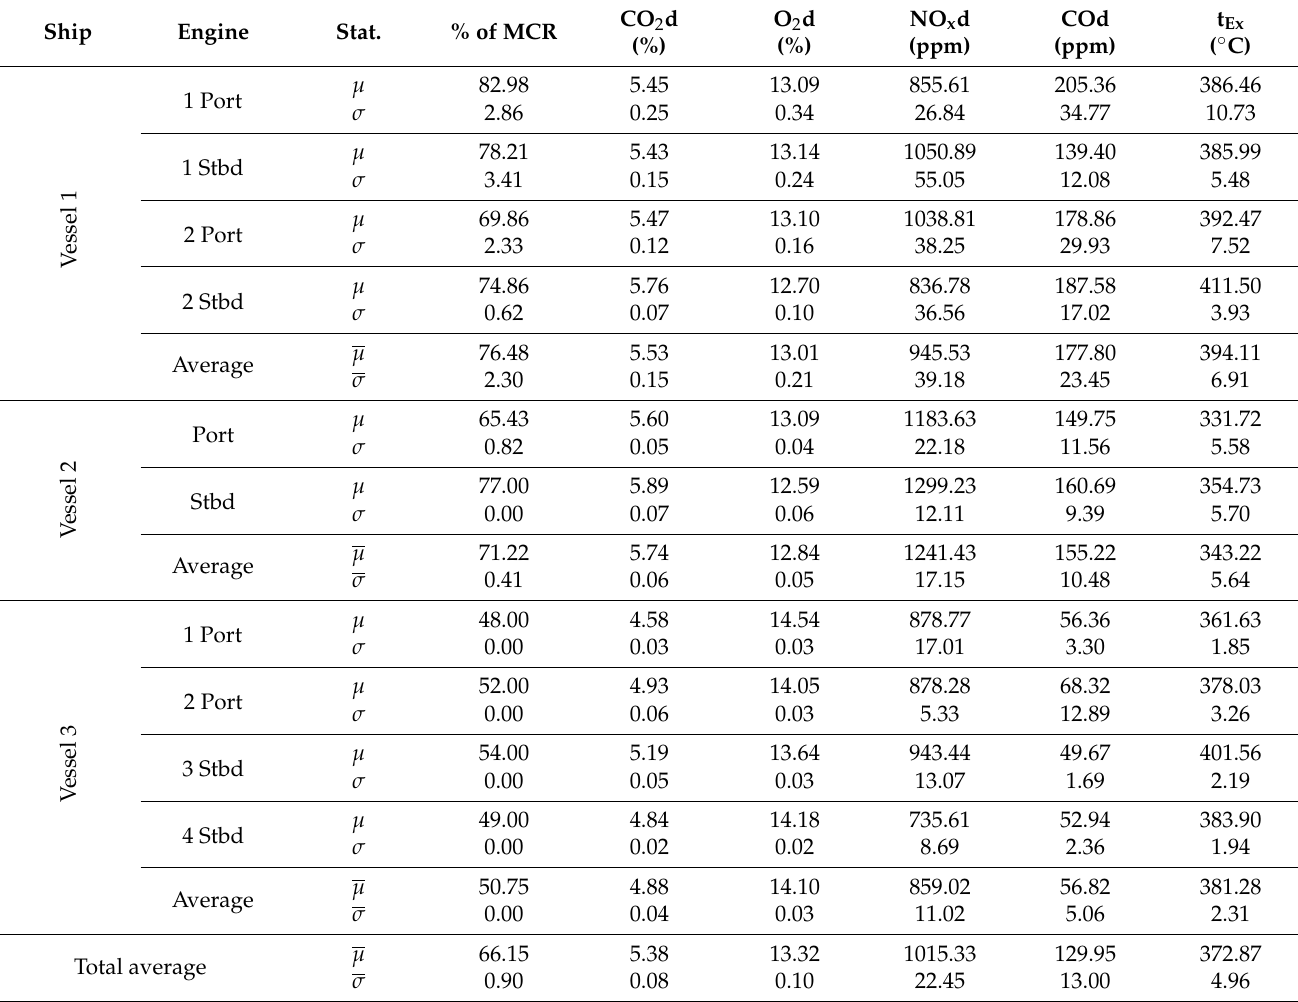
Table 2. Basic statistics (mean µ and standard deviation σ ) of measured and analysed quantities for all vessels and their associated port (P) and starboard (S) engines with calculated average